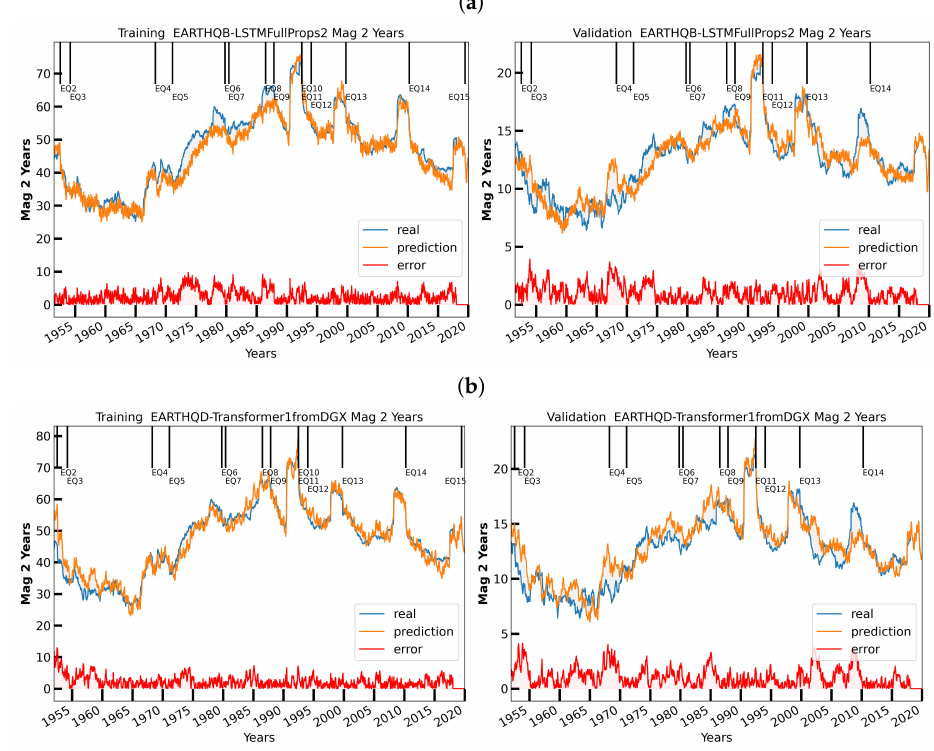
Figure 18. Two-year m bin ( F : ∆ t , t ) results for ∆ t = 104 weeks (training on left, validation on the right) are given for 2 methods (TFT not available). The earthquakes marked are listed in Table 1. ( a ) Two-year LSTM results for m bin ( F : ∆ t , t ) for ∆ t = 104 weeks. ( b ) Two-year science transformer results for m bin ( F : ∆ t , t ) for ∆ t = 104